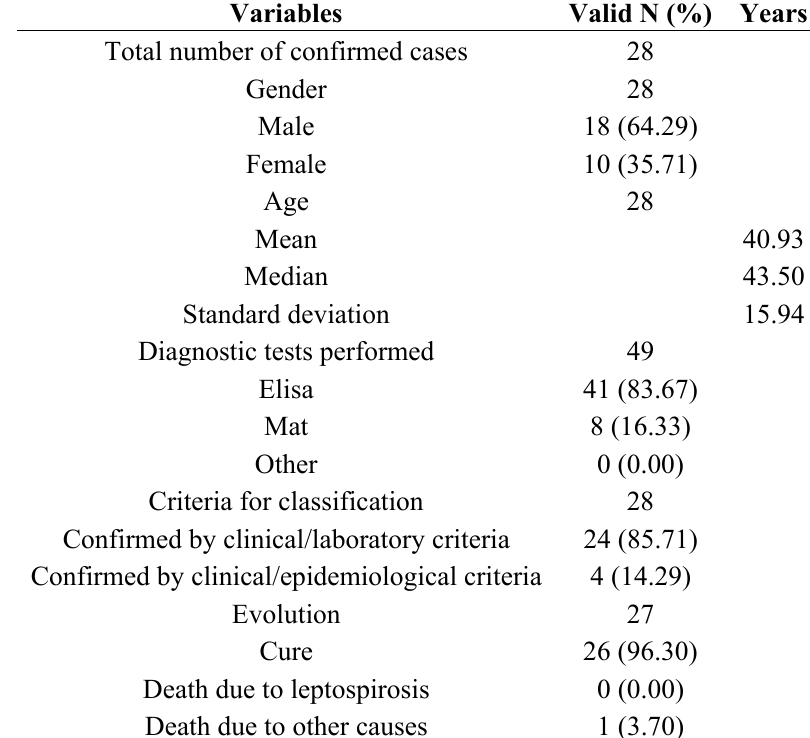
Table 3. Descriptive statistics of hospitalized cases with leptospirosis in Nova